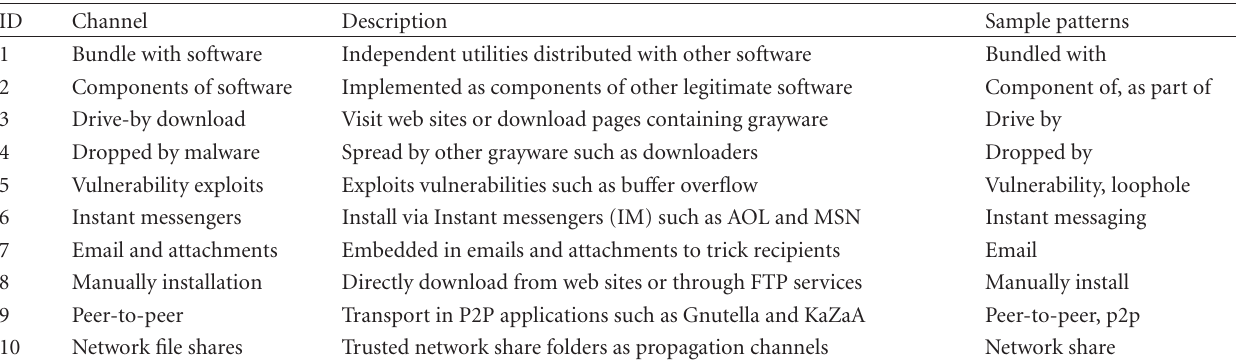
Table 4: Installation mechanisms employed by grayware species.